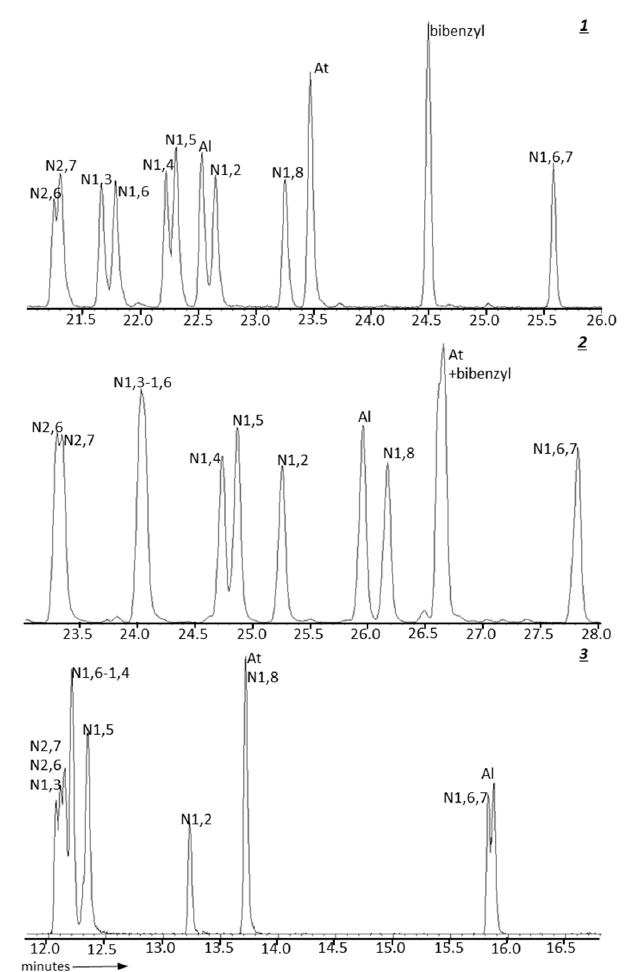
Figure 1. Elution order of dimethylnaphthalenes, trimethylnaphthalene, acenaphthylene (Al), acenaphthene (At) on phenyl arylene ( 1 ), 50% phenyl-polysiloxane ( 2 ) and SLB-ILPAH ( 3 ) stationary phases. For abbreviations see Table 2.